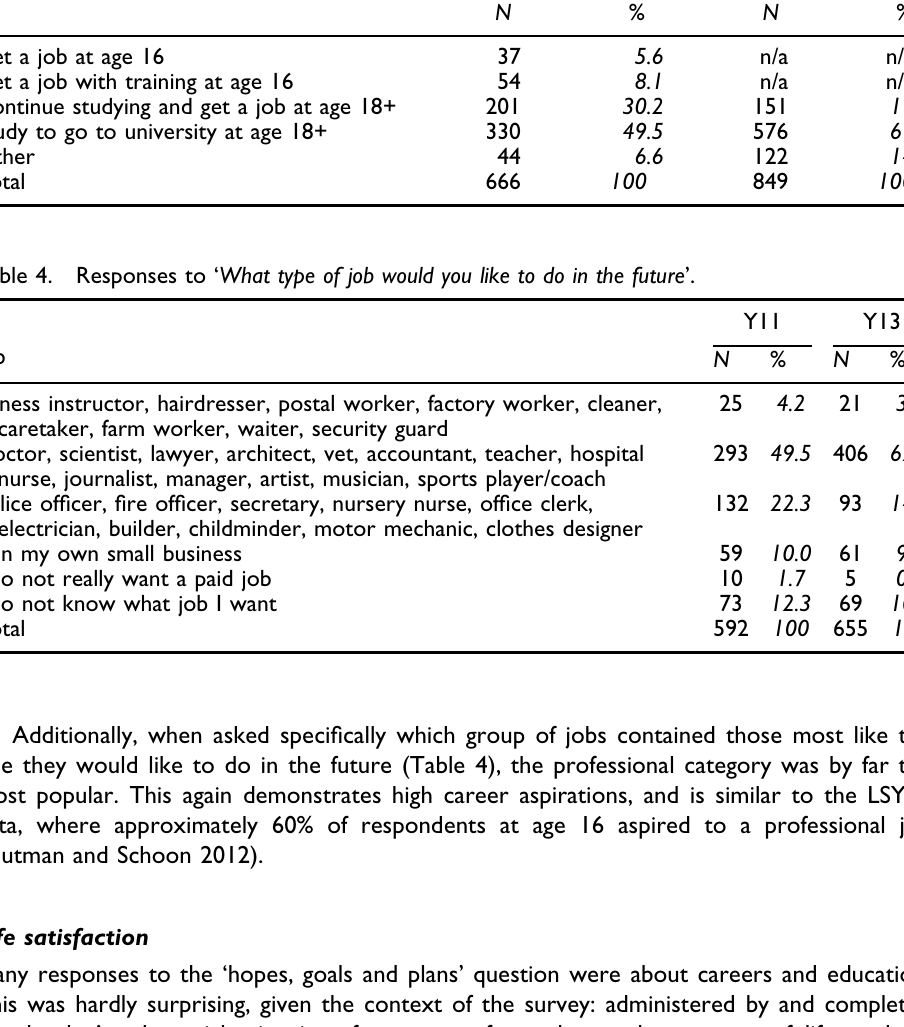
Table 3. Responses to ‘ What do you hope to do when you leave school or college? ’. Get a job at age 16